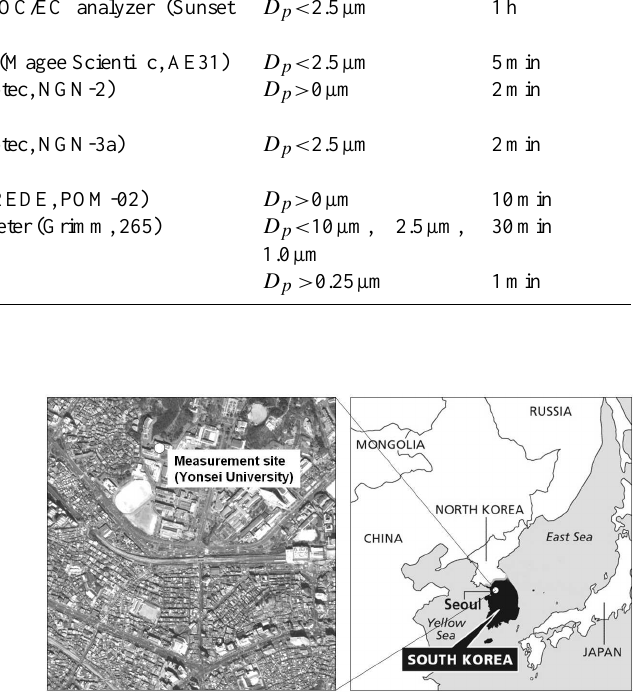
Fig. 1. Area map of the measurement site (37.57 ◦ N, 126.94 ◦ E) in Seoul,